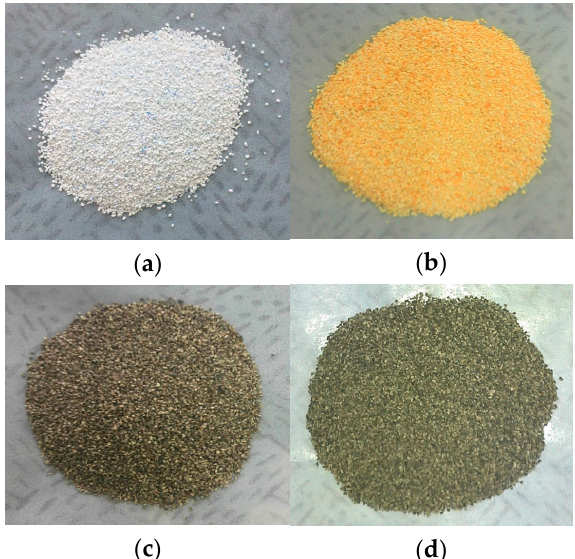
Figure 2. The Pt/Barium hexaaluminate ( a ) before Pt doping, ( b ) after impregnation, ( c ) after calcination, and ( d ) after reduction.